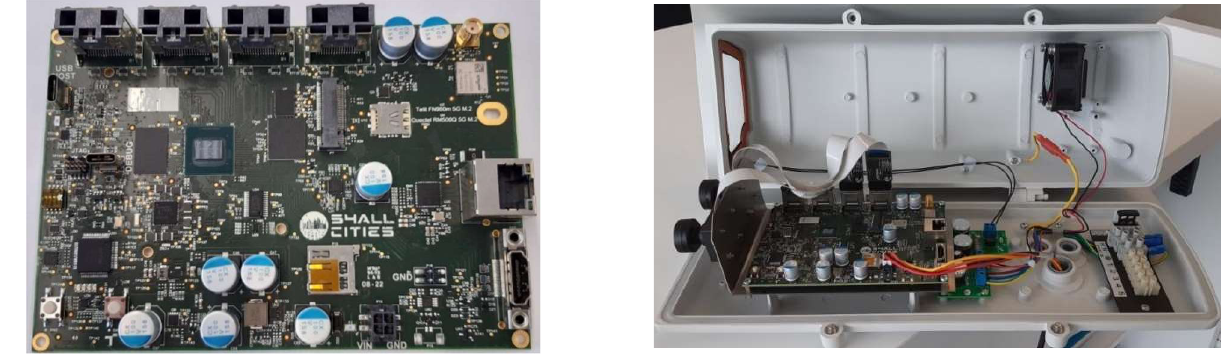
inspection Figure 3. S4AllCities Hardware platform based on the I.MX8M PLUS and enclosed as a security inspection camera.